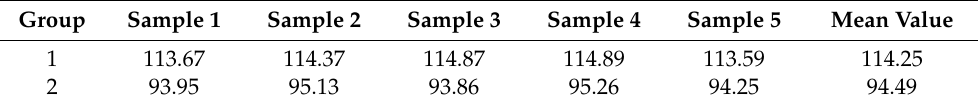
Table 8. Five-day average desulfurization efficiency of bacterial desulfurization.